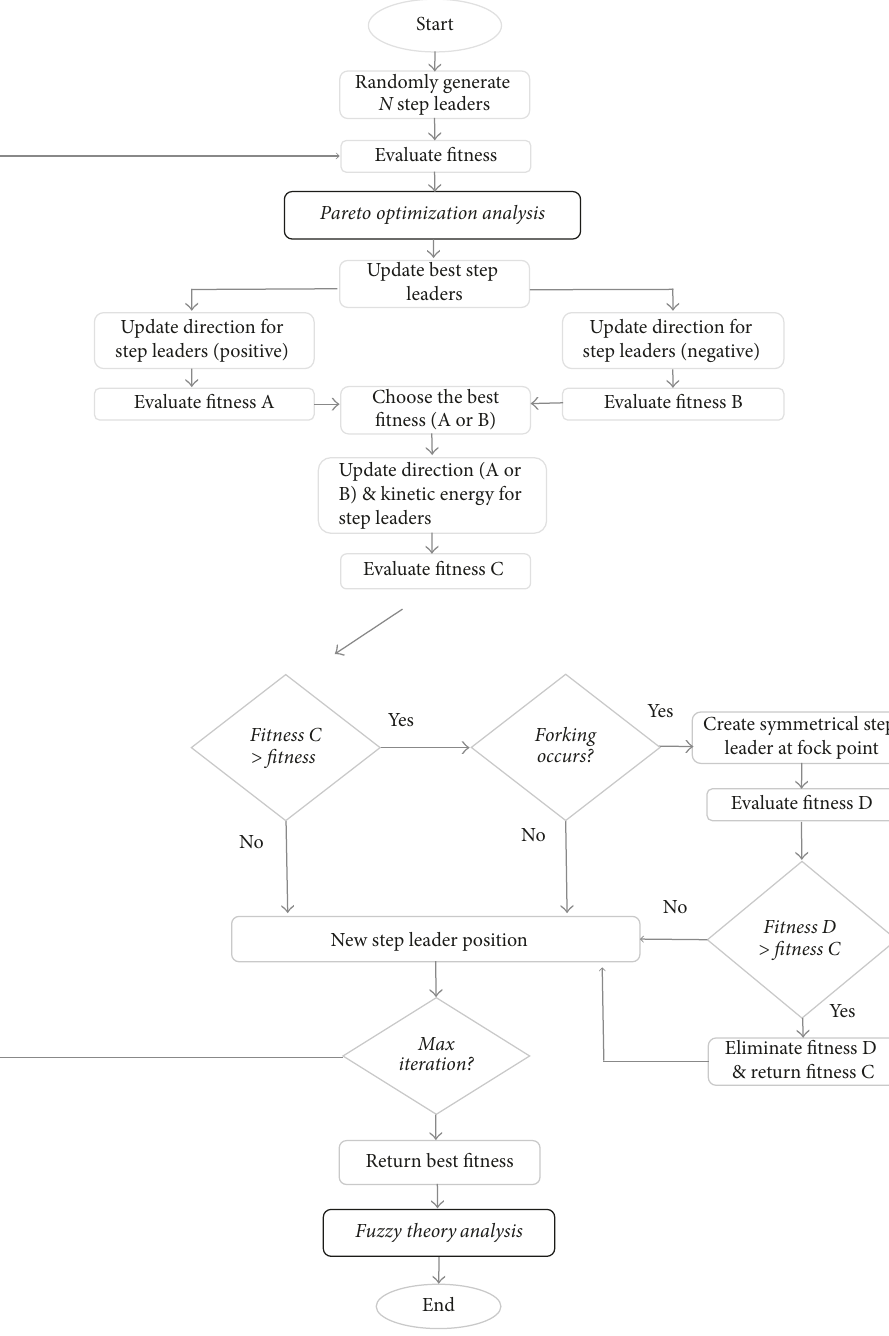
Figure 9: Flowchart for MLSA method to get minimum fitness with Pareto-Fuzzy